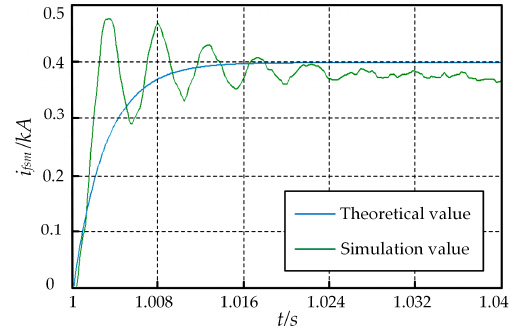
Figure 5. Theoretical value and simulation value of i fsm .